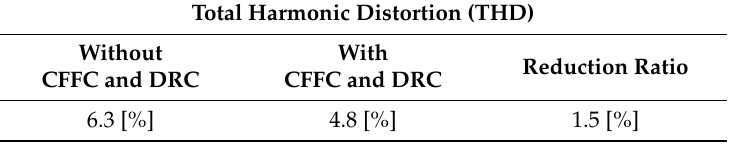
Table 7. Experiment results of GCI system phase current THD when 5th, 7th harmonics injected grid